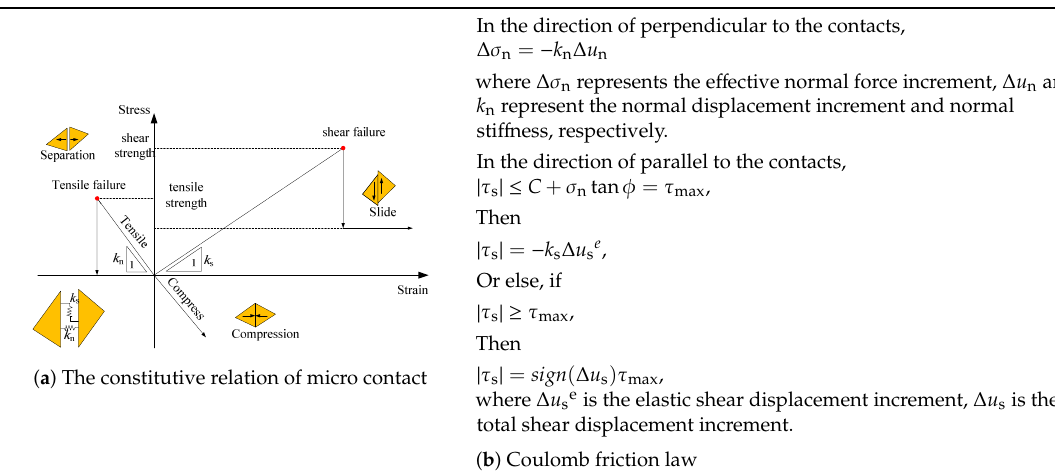
Table 3. Failure criterion of the triangular blocks in Universal Discrete Element Code (UDEC).